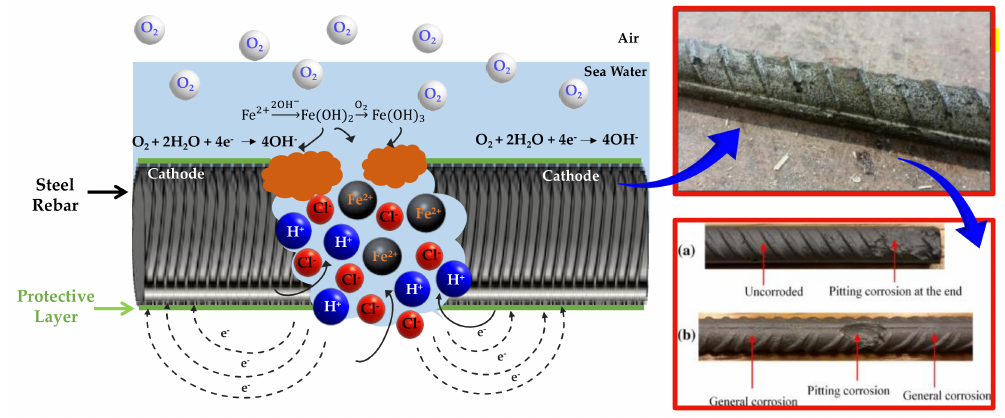
Figure 7. Pitting corrosion [158–160].